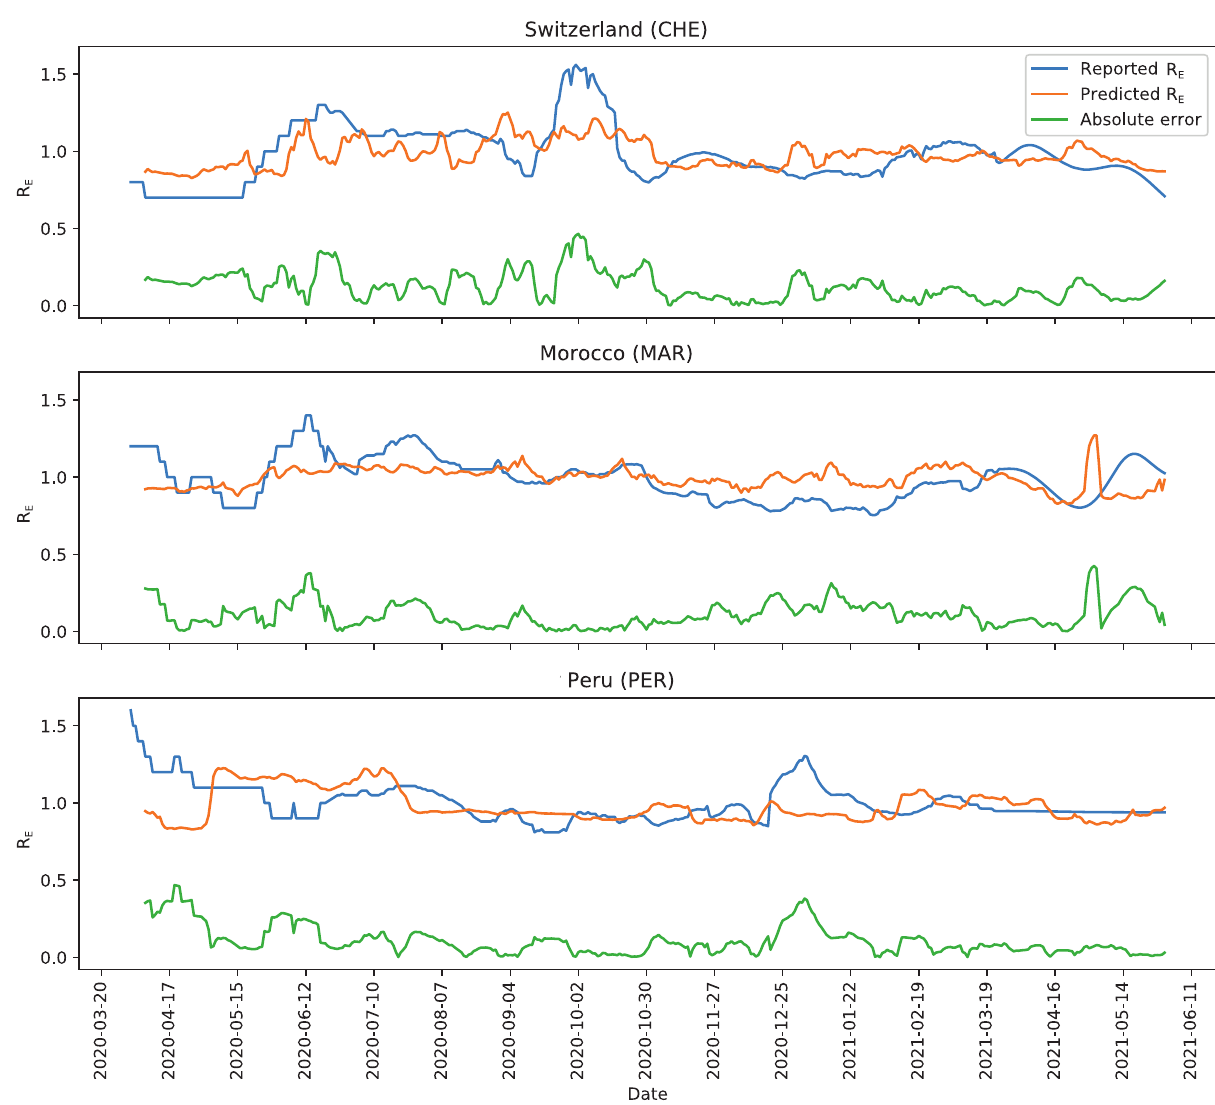
Fig 3. Reproduction rate predictions for three sample countries. R The ground R E is shown in blue, and the absolute error (absolute difference between the prediction and ground truth) in